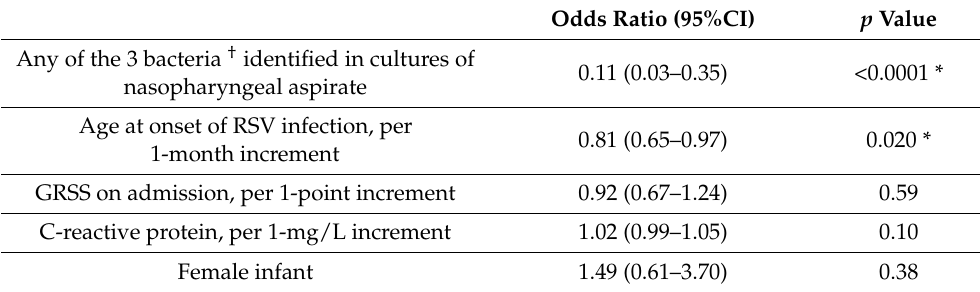
Table 2. Logistic regression analysis for predicting neutropenia <1.0 × 10 9 /L in infants with RSV infection. Odds Ratio (95%CI) p